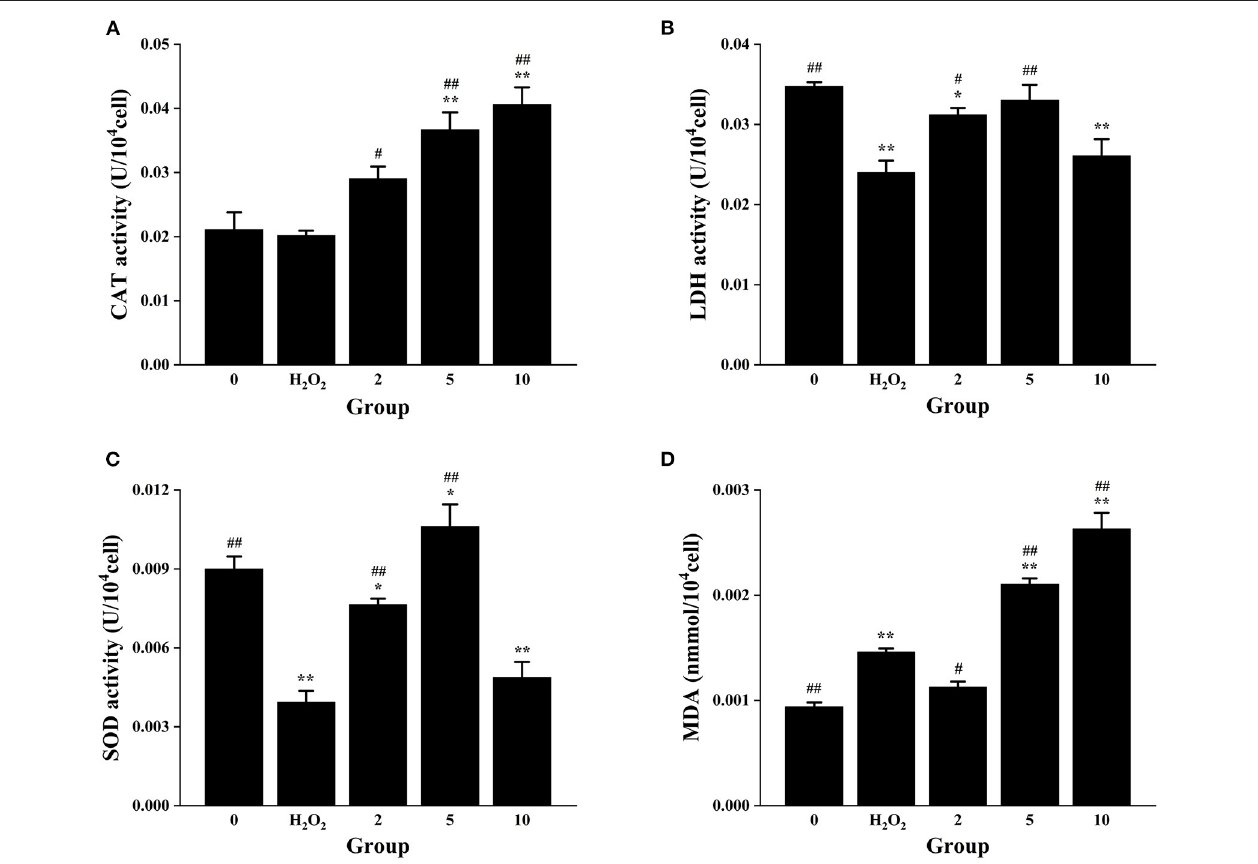
FIGURE 4 | Effects of L. aureum on the antioxidant enzyme activity and lipid peroxidation in H 2 O 2 − induced RAW264.7 cells. (A) The effect on the activity of CAT. (B) The effect on the activity of LDH. (C) The effect on the activity of SOD. (D) The effect on the cellular MDA level. The results are expressed as the mean ± SD of three independent experiments. * p < 0.05 and ** p < 0.01 compared with H 2 O 2 -untreated group, # p < 0.05 and ## p < 0.01 compared with H 2 O 2 group were considered statistically significant differences.